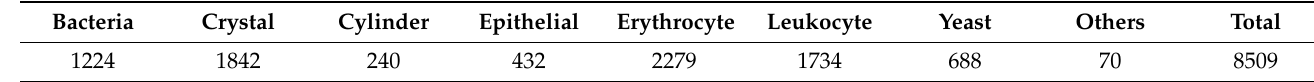
Table 1. Urine sediment particle classes and numbers in the data set.